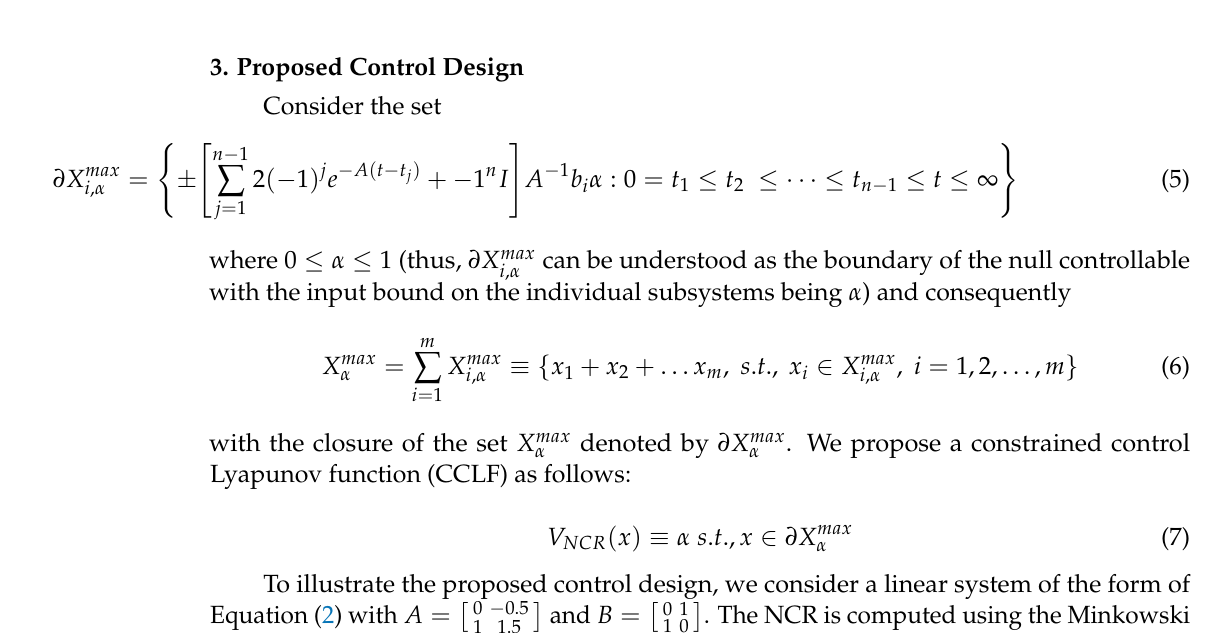
( t ) = 0 i f f V t → ∞ x